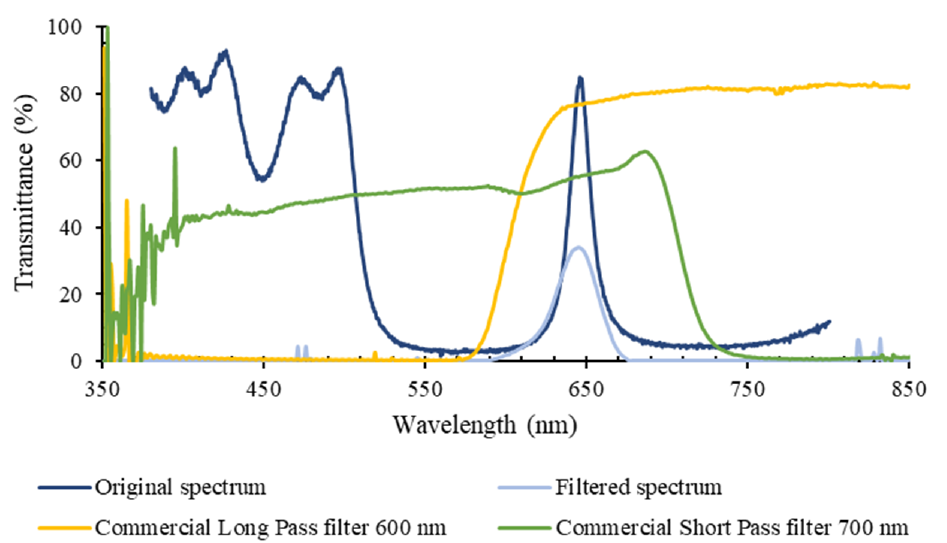
Figure 8. Experimental transmittance (%) vs. wavelength (nm) spectrum ( n = 3), of the 649 nm bandpass filter, measured with the spectrophotometric top bench setup: without using additional commercial filters (dark blue line); using the commercial short pass and long pass filters (light blue); and spectra of the commercial long pass (yellow) and short pass (green) filters, used to remove high transmittance components outside the relevant spectral bands (as listed in Figure 6b).